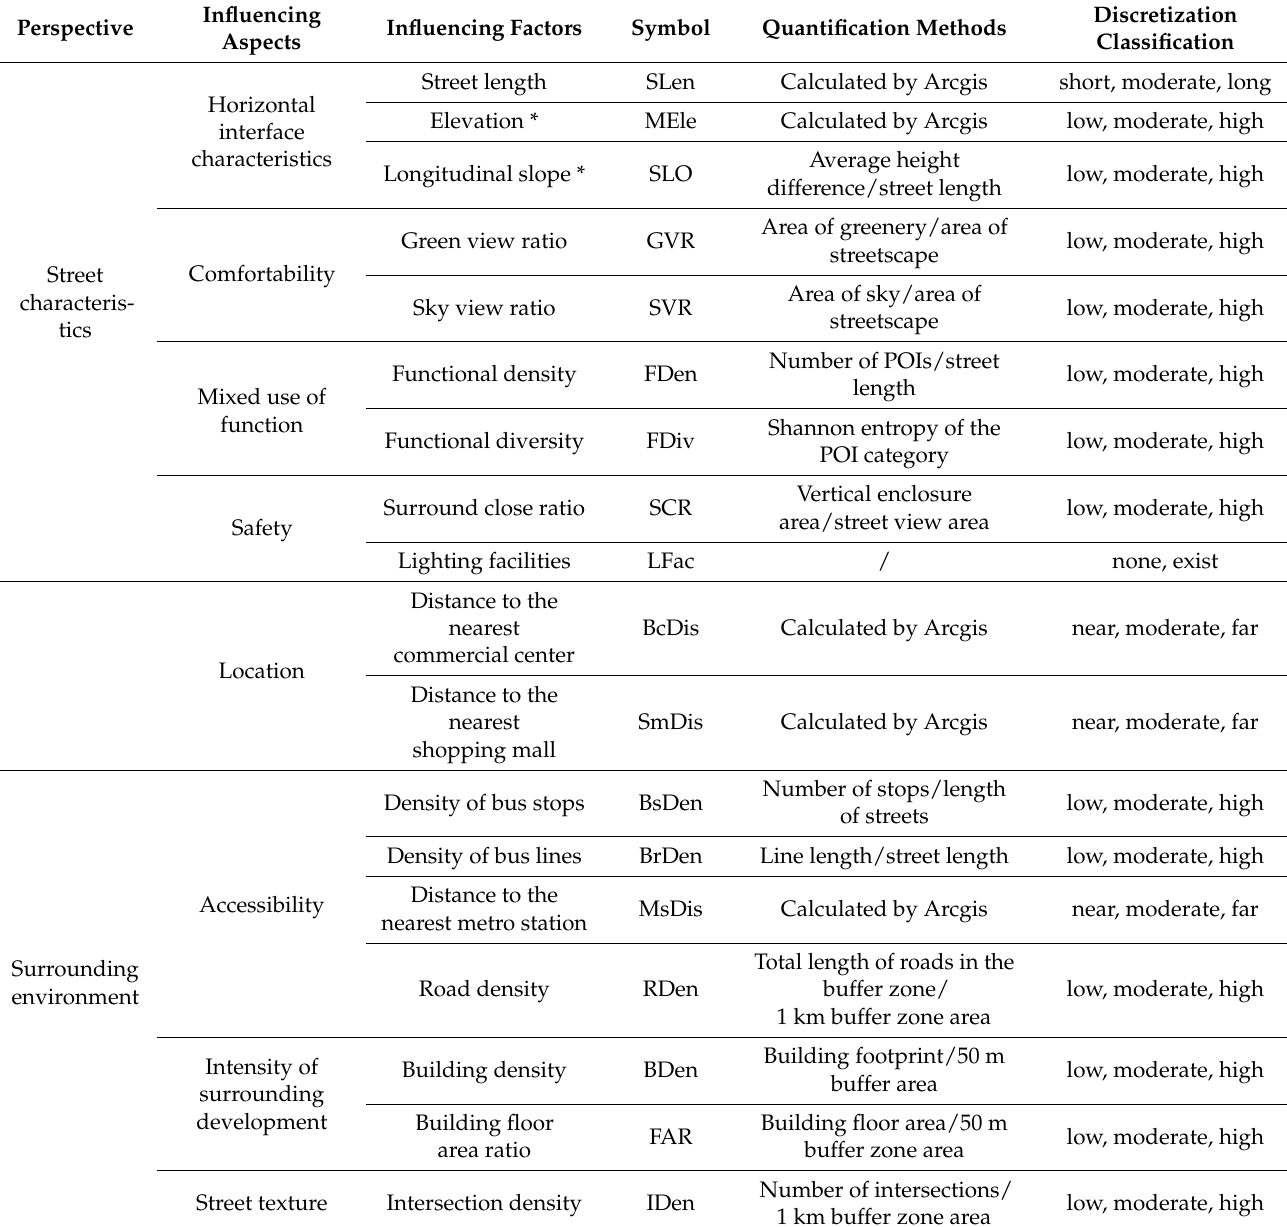
Table 2. Influencing factors and quantitative methods of street vitality in mountainous